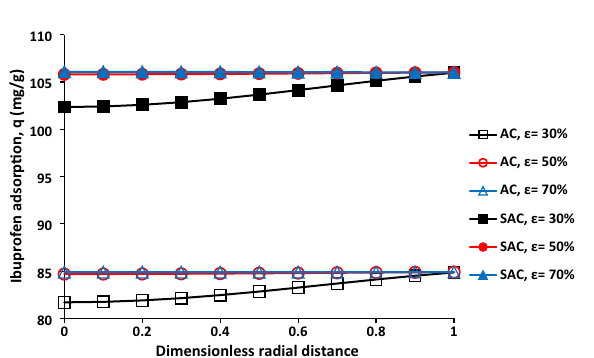
Figure 7. Ibuprofen adsorption as a function of dimensionless radial distance for AC ( a ) and SAC ( b ) with different particle porosity, initial ibuprofen concentration = 100 mg/L, T = 298 K, pH = 2, adsorbent dosage of 0.5 g/L, and particle radius = 163